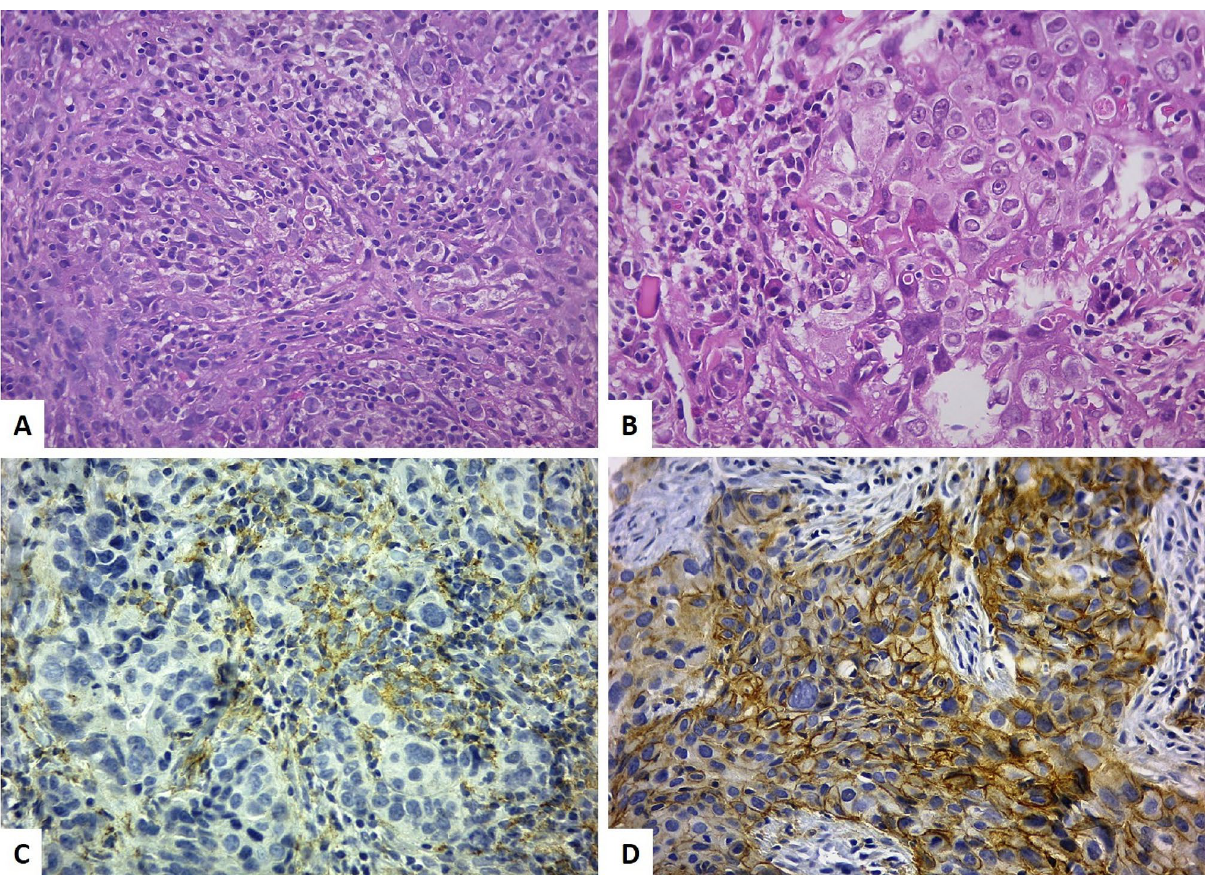
Figure 1. ( A ) triple negative breast carcinoma: scattered tumor infiltrating lymphocytes (core biopsy, H&E, original magnification 400 ×). ( B ) triple negative breast carcinoma: aggregates of tumor infiltrating lymphocytes (core biopsy, H&E, original magnification 400 ×). ( C ) luminal-like, HER2 negative breast carcinoma: PD-L1 positive tumor infiltrating lymphocytes (core biopsy, immunohistochemistry, original magnification 400 ×). ( D )